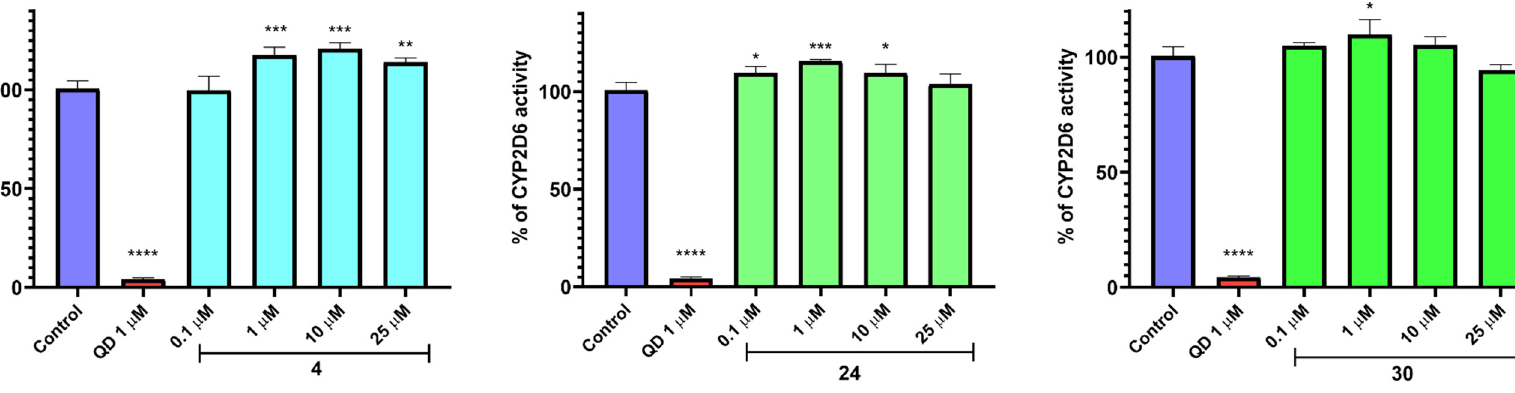
Figure 6. The influence of 4 , 24 , 30 , and reference inhibitor quinidin (QD) on CYP2D6 activity. Statistical significance (* p < 0.05,** p < 0.01, *** p < 0.001, **** p < 0.0001) was analyzed by Graph Pad Prism 8.0.1 software using one-way ANOVA and Bonferroni’s multiple comparison post test. The compounds were examined in triplicate.